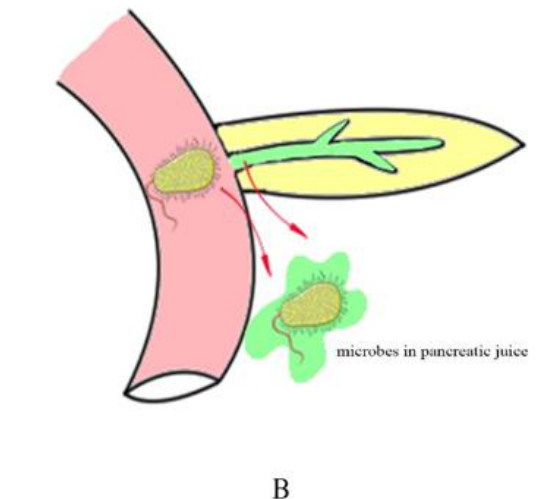
Figure 1. Different pathways of intestinal microbial leakage in PD. ( A ) shows that microbes leak from the pancreaticojejunostomy anastomosis. ( B ) shows that microbes leak by bacterial transloca- tion.